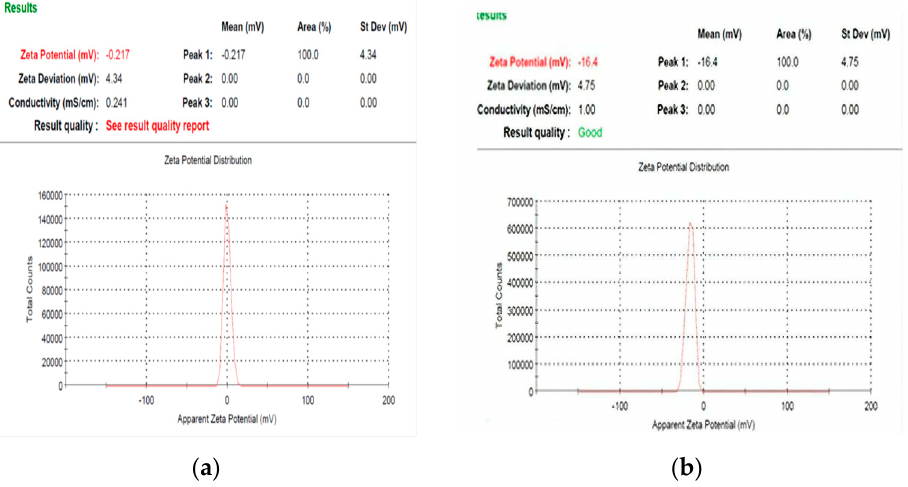
Figure 7. Zeta potential analysis of biosynthesis: nanocellulose ( a ) and Ulva/Ag/cellulose nanocom- posites ( b ) derived from U. lactuca